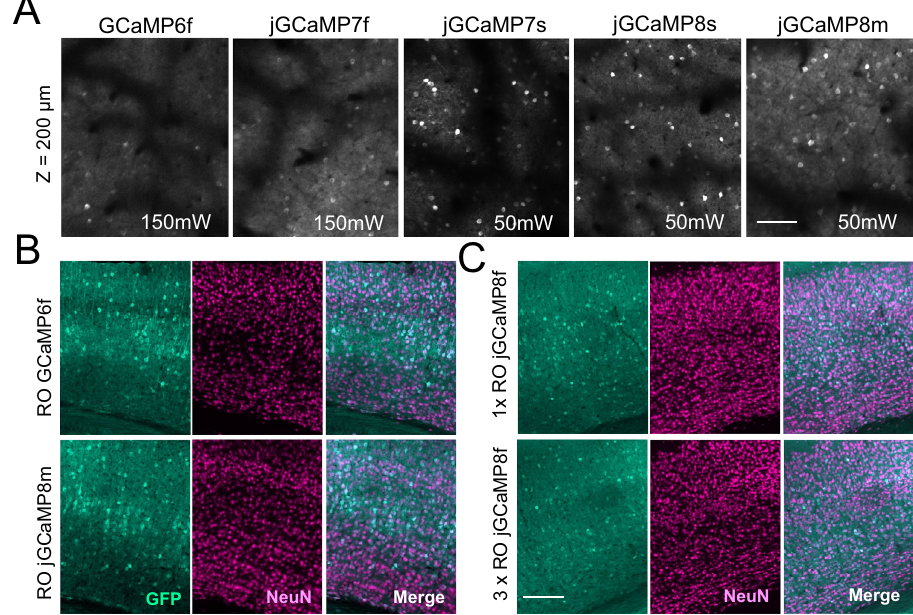
Fig. 2 | In vivo GECI screening after retro-orbital (RO) virus injections. A Representative example images acquired by two-photon microscopy from fi ve differentGECIsacquiredsixweeksafterROvirusinjections.NotethatGCaMP6fand jGCaMP7f were not detectable at reasonable illumination intensity (40 – 50mW at 920nm). The images shown from GCamp6f and jGCaMP7f were acquired using 150mW laser power for testing purposes only. The recently developed jGCaMP7s, 8s, and 8m were suf fi ciently bright using 50mW. Scale bar indicates 250 μ m. All